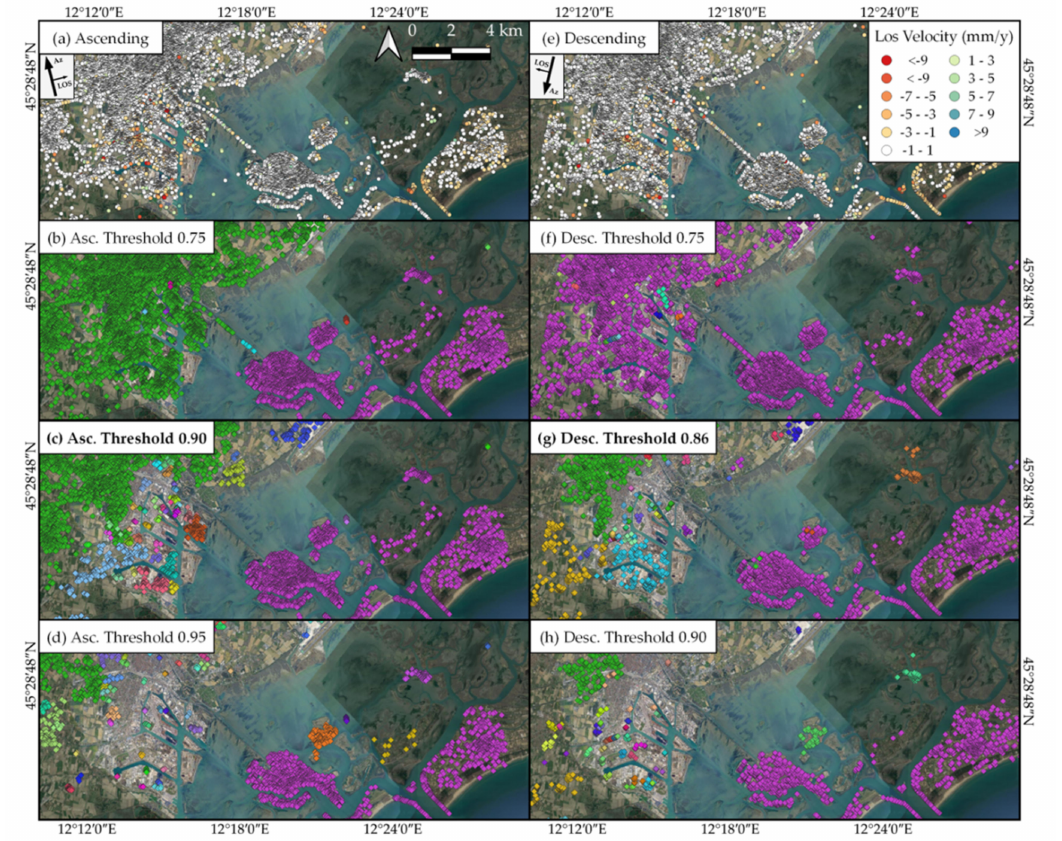
Figure 12. The Venice Lagoon and surrounding areas with: PS distribution in ( a ) ascending mode and ( e ) descending mode (colour code indicates different LOS velocity ranges), and their subdivision in families with CAPS method by using different threshold values for ( b – d ) ascending and ( f – h ) descending (different colours indicate different PS